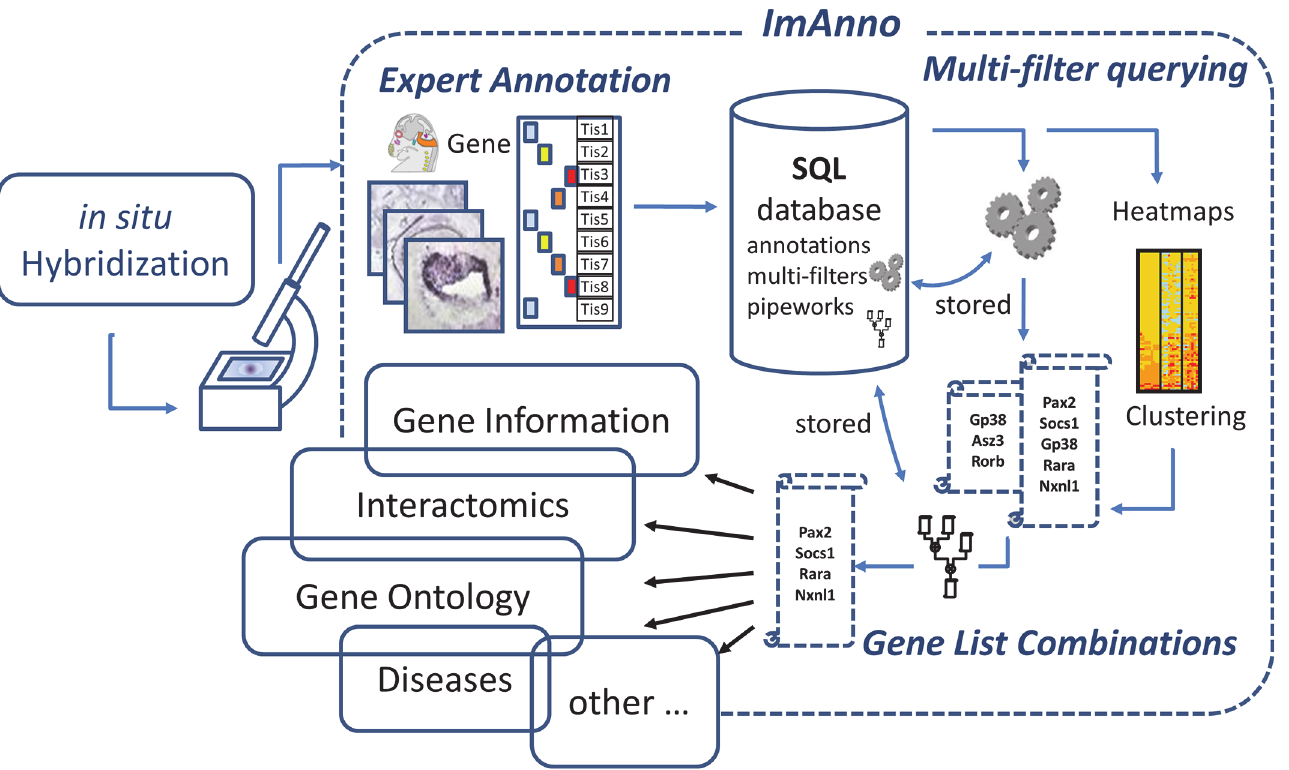
Fig 2. Overview of the ImAnno framework. The ISH images and annotations are integrated in a relational database. Filters and combinations of filters can be defined and stored by the user, providing gene lists for further integrated analysis with local and external databases (Gene information, Interactomics data, Gene Ontology ...